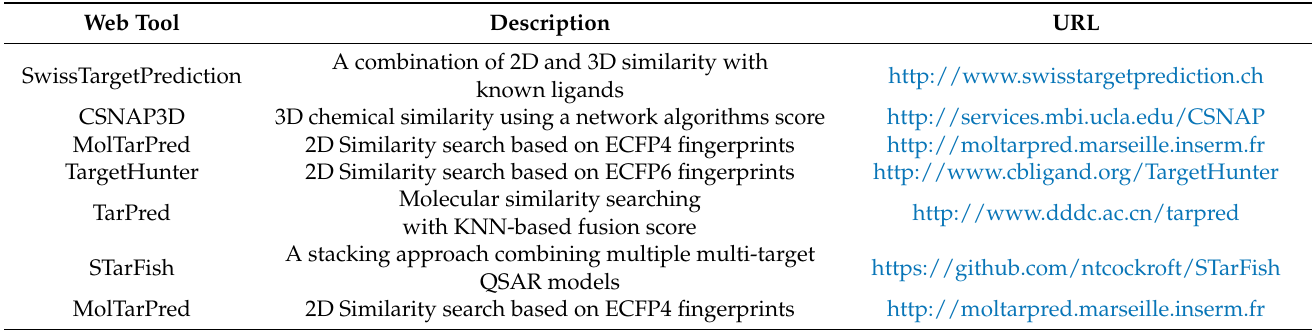
Table 1. Summary of the different ligand-based web tools herein discussed (access date: 1 June 2021). Web